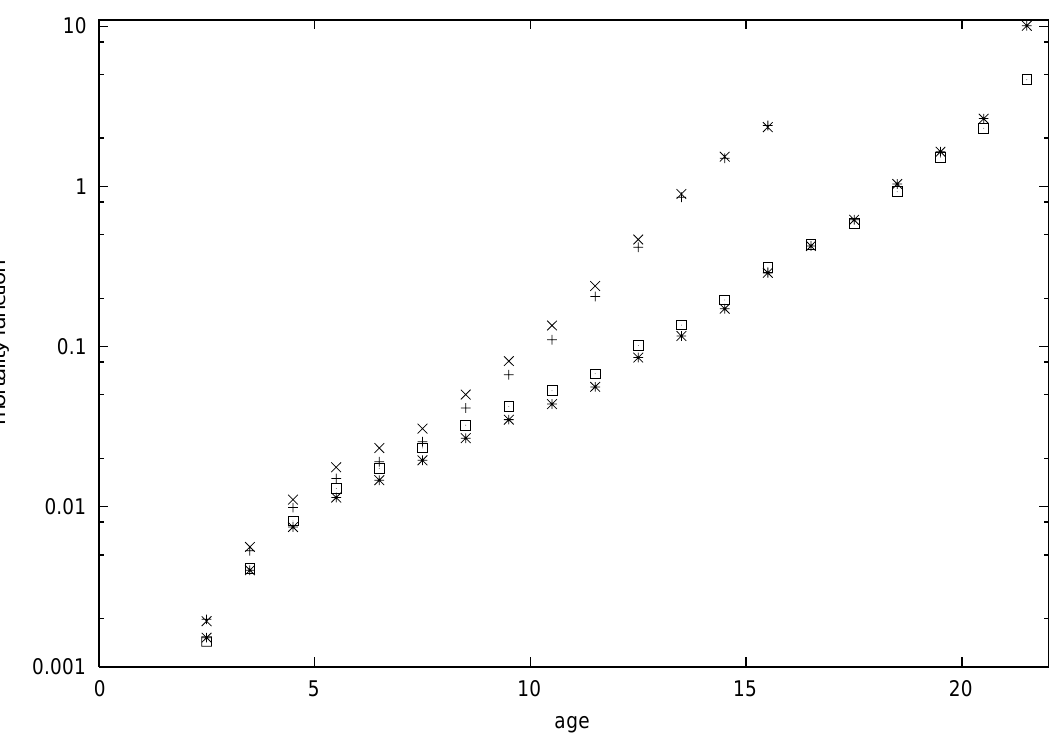
Fig. 7 – Comparison of traditional ordered crossover (x, squares) with better random crossover (+, stars) showing little difference. The Verhulst deaths appear at all ages (+, x) or only at birth (stars, squares).